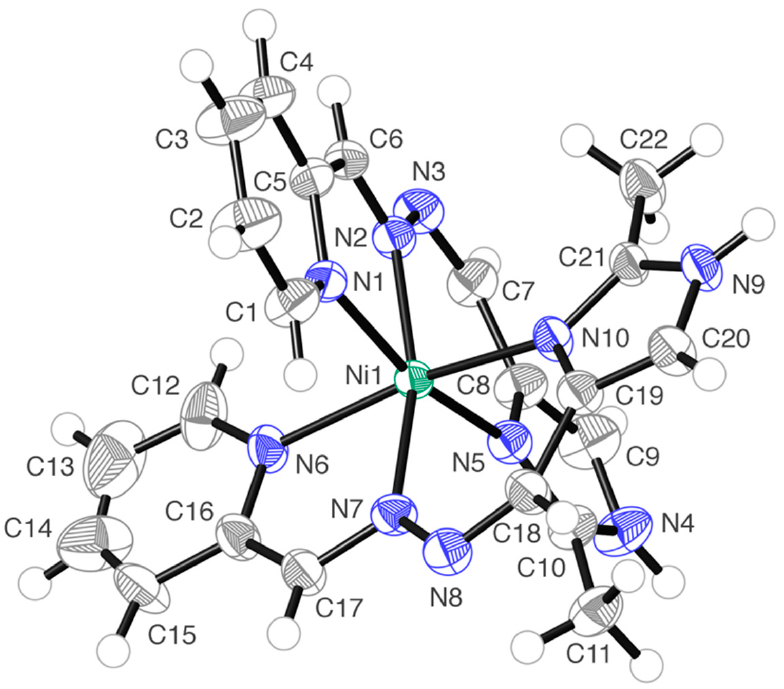
Figure 2. An ORTEP drawing of the complex cation [Ni(HL Me ) 2 ] 2+ in 2 · H 2 O · Et 2 O with an atom-numbering scheme (ellipsoids are drawing at a 30% probability level).